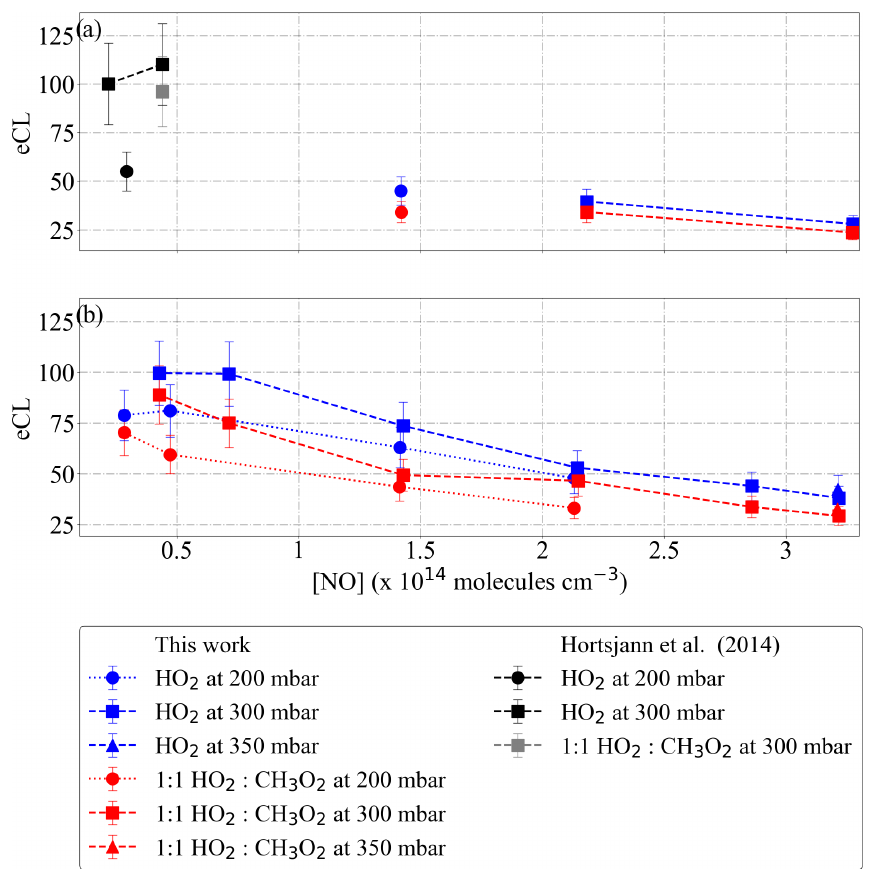
Figure 7. eCL versus [NO] measured for (a) DUALER I and (b) DUALER II at inlet pressures between 200 and 350mbar. The radical source flow tube is held at a pressure of 500mbar. The results from Horstjann et al. (2014) are also depicted for